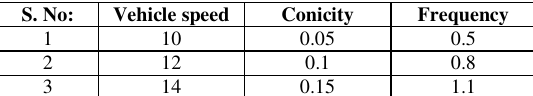
Table 2: Simulated Cases between Vehicle speed, Conicity and Frequency